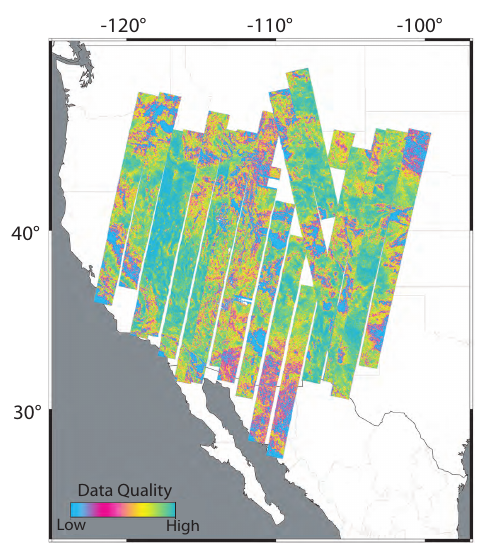
Figure 1. Spatial variations of InSAR data quality for single interferograms spanning 9 months to 2 years for tracks used in the survey for anthropogenic deformation. This map was used to determine the limits of the data processing—low values indicate poor data quality (see text for details).